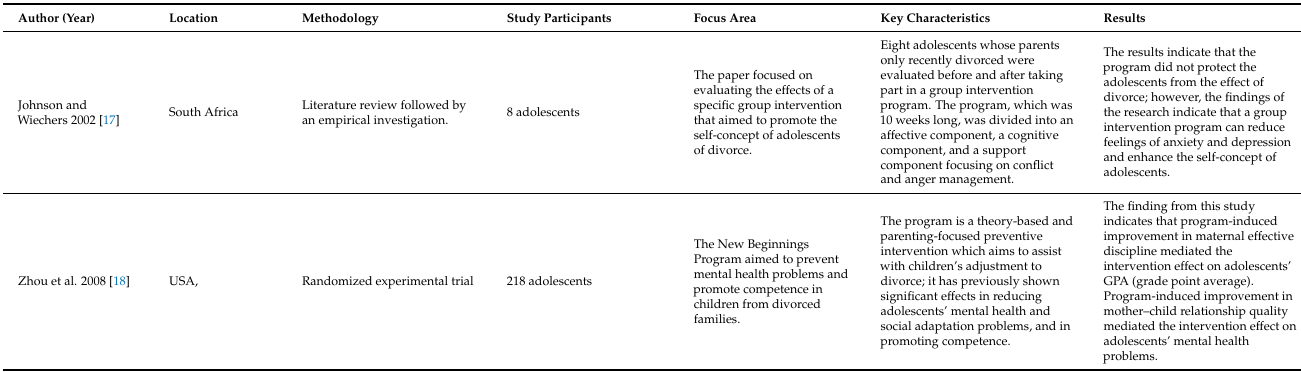
Figure 1. Flow diagram of review. * The number of records identified from each database or register searched. ** The number of records excluded by the researcher. Table 1. Data extraction.